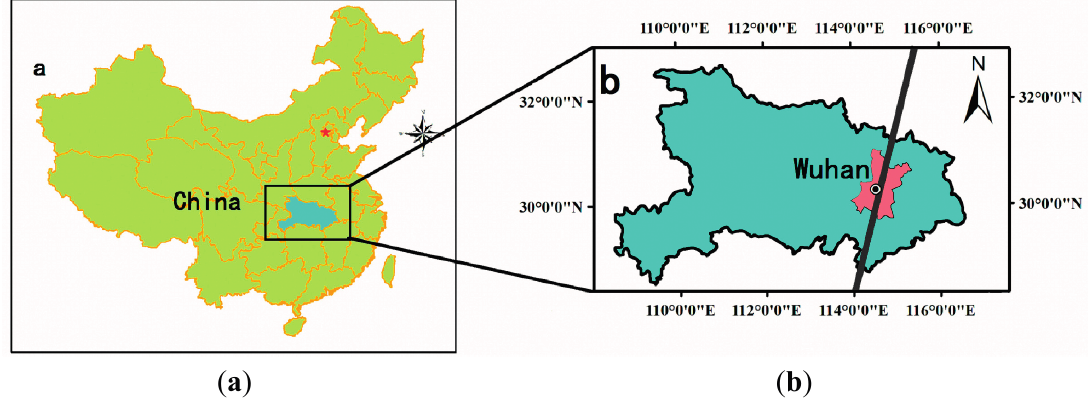
Figure 1. Location of study area: ( a ) location of Hubei Province, China and ( b ) location of Wuhan in Hubei Province (solid black line represents the CALIPSO track passing over